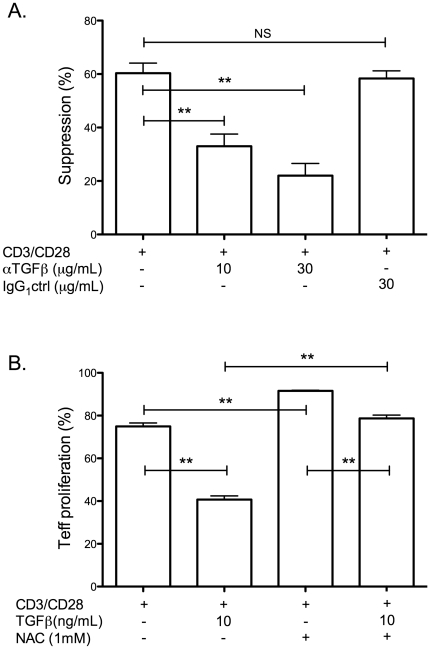
Suppression by Tregs is partially dependent on TGFβand the suppressive effects of exogenous TGFβ on Teff proliferation can be overcome with NAC.(A) Suppression assays were performed as outlined with a 1∶1 ratio of Tregs:Teff with and without TGFβ neutralizing antibodies at the indicated concentration, or nonspecific isotype control antibodies (IgG1), and anti-CD3/CD28 beads for 3 days. Similar results were obtained in at least three identical experiments, each performed in triplicate. The data shown represents a compilation of all of these experiments. (B) Purified, CFSE-labeled Teffs, without Tregs, were stimulated in the indicated conditions for 4 days with and without the addition of TGFβ (10 ng/mL) and NAC (1 mM). Proliferation was measured by flow cytometric evaluation of CFSE staining. The data shown is representative of three identical experiments (NS – not significant, ** p≤0.01).